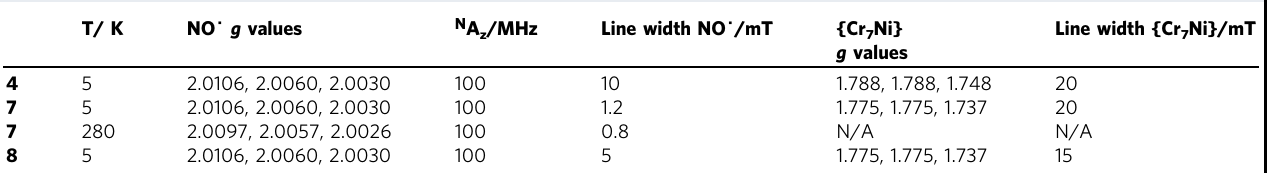
Table 1 EPR simulation parameters for compounds 4, 7 and